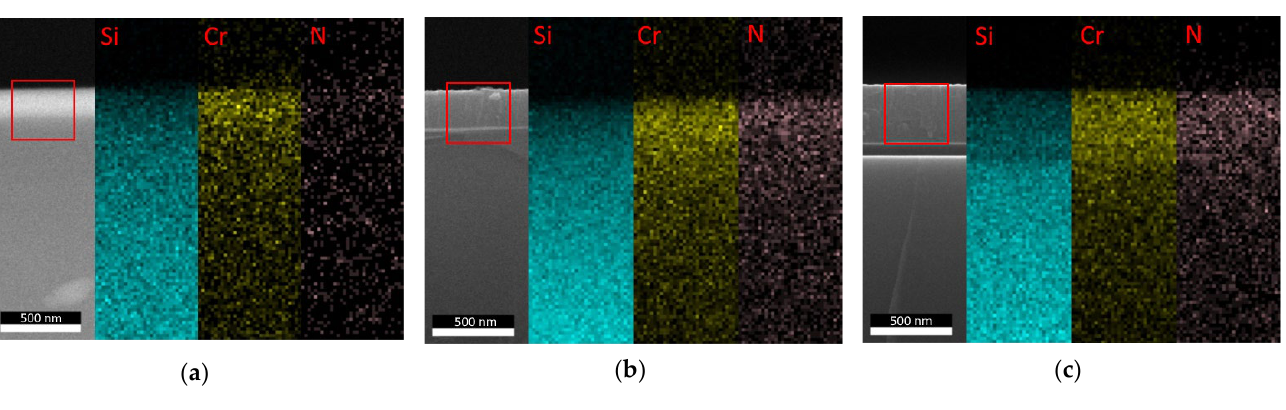
elemental maps, respectively. maps, respectively.